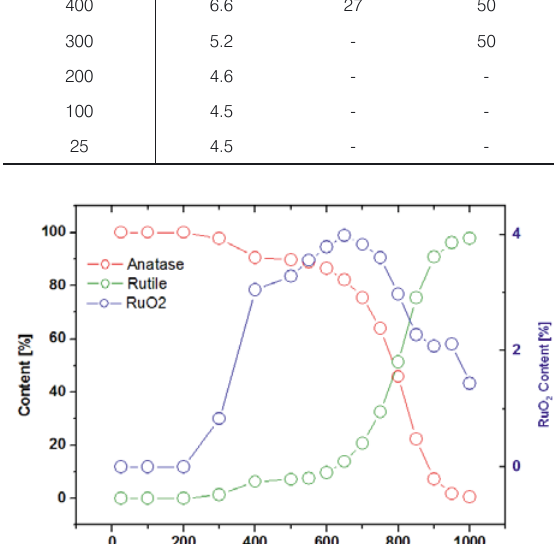
Figure 2. The dependence of crystal phase evolution of TiRu1 on Table 2. Characteristics of the prepared titania samples doped with variable amounts of RuCl